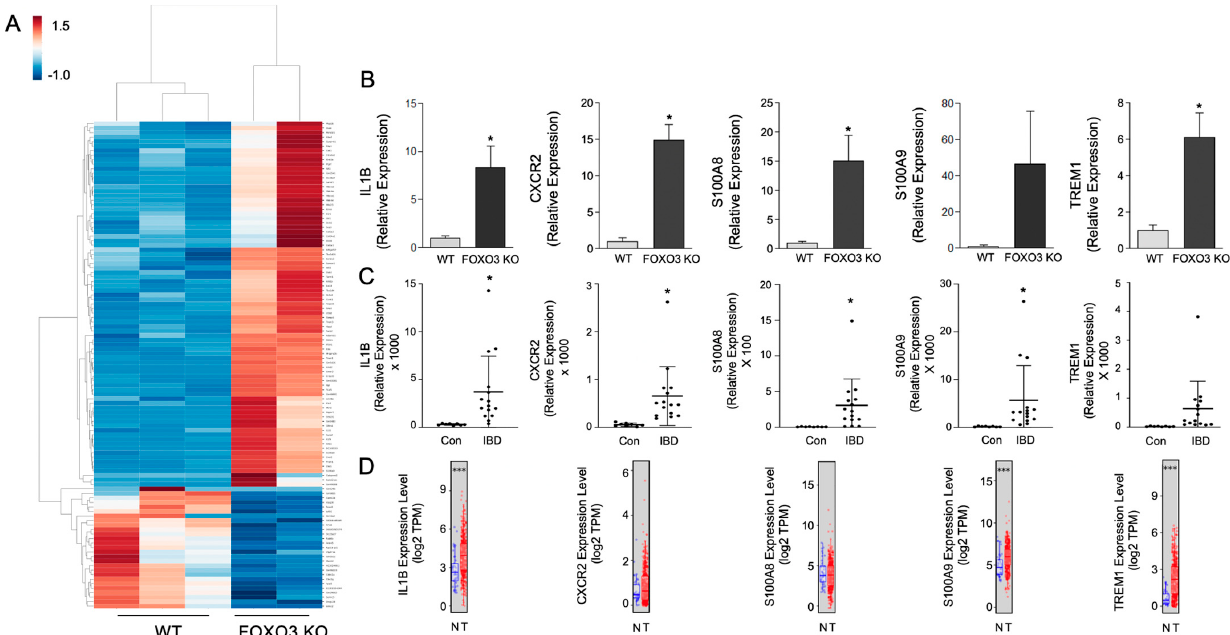
Figure 5. FOXO3-mediated differentially expressed genes in macrophages with established roles in IBD and colon cancer. ( A ) A heatmap of the top DEGs specific to FOXO3-deficient peritoneal macrophages relative to control (>|1.5|-fold change, FDR < 0.05). ( B ) Validation of select FOXO3 dependent IL-1B, CXCR2, S100A8, S100A9 and TREM1 transcripts in macrophages (qPCR, n = 3, * p < 0.05). ( C , D ) Altered IL-1B, CXCR2, S100A8, S100A9 and TREM1 levels in IBD and human colon cancer patient transcriptomes ( n = 23, GSE4183; n = 498, TCGA, * p < 0.05, *** p < 0.001).